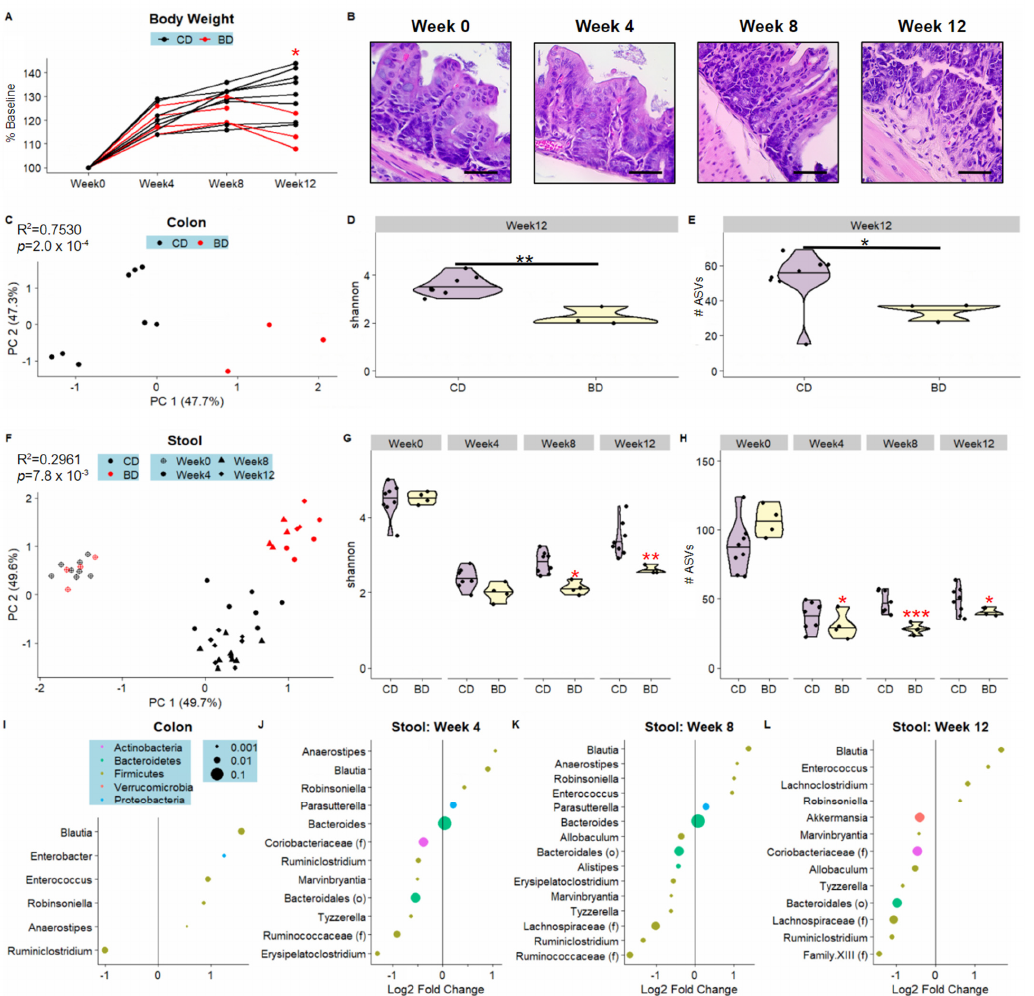
Figure 4. Microbiome dysbiosis induced by dietary biotin deficiency occurs prior to changes in body weight and intestinal pathology. ( A ) Line graph showing changes in body weight at the study timepoints, with each line representing one mouse. ( B ) Representative hematoxylin and eosin-stained colon images of biotin-deficient diet (BD) mice at week 0, 4, 8 and 12. The scale bar represents 50 microns. Beta-diversity was visualized using principal coordinates analysis in the colon ( C ) and stool ( F ), with one dot representing one sample and colored according to Diet (CD, BD). R 2 and p -values associated with Diet are labeled in the upper left corner of each plot. Violin plots compare alpha-diversity metrics, shannon (left) and #ASVs (right) between diet groups in the colon ( D , E ) and stool ( G , H ). For the colon data, significance was assessed through Student’s t -test, * p < 0.05, ** p < 0.01. For the longitudinal data, significance was assessed through linear mixed-effects models (LMEM) with Diet as a fixed effect and MouseID as a random effect. A red asterisk indicates that the BD trajectory is significantly different from the CD trajectory; * p < 0.05, ** p < 0.01, *** p < 0.001. Per-genus association testing for the colon ( I ), stool week 4 ( J ), stool week 8 ( K ), and stool week 12 ( L ) was performed using linear models fitted to log-transformed, TSS normalized count data with Diet as the predictor variable. Genera which were significantly differentially abundant ( q < 0.05) in BD compared to CD are represented as dots colored by Diet and sized according to relative abundance, with the legend for all differential taxon plots shown in ( I ). Relative to the control group, genera with positive log2foldchange are enriched in